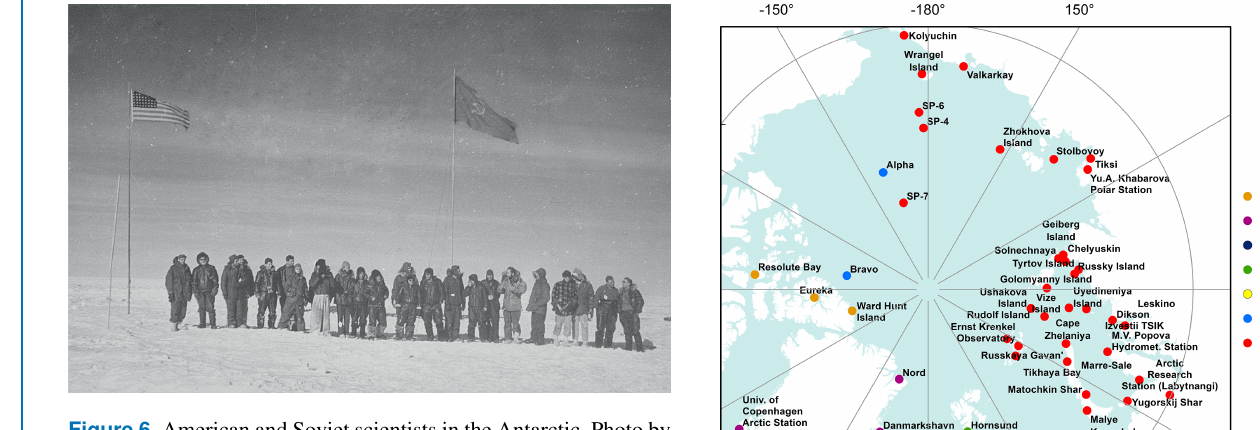
Figure 6. American and Soviet scientists in the Antarctic. Photo by Alexander Maksimov (Rodnikov et al., 2009).